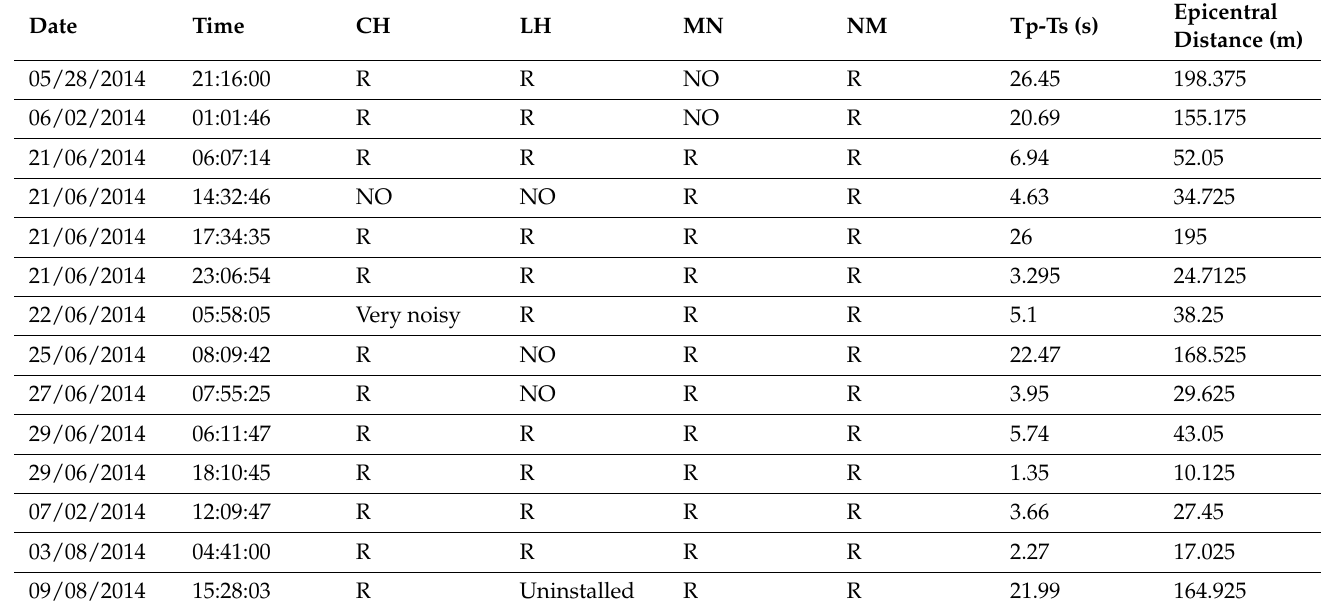
SSR analysis. Table 1. List of the 14 earthquakes recorded by the four stations in Fond Parisien; seven events recorded (R) by all stations were used for the SSR computations (not recorded is marked by “NO”). The geographical coordinates (latitude and longitude) are in decimal degree WGS 1984. Tp-Ts is the epicentre distance which corresponds to the delay time between the P and S waves.